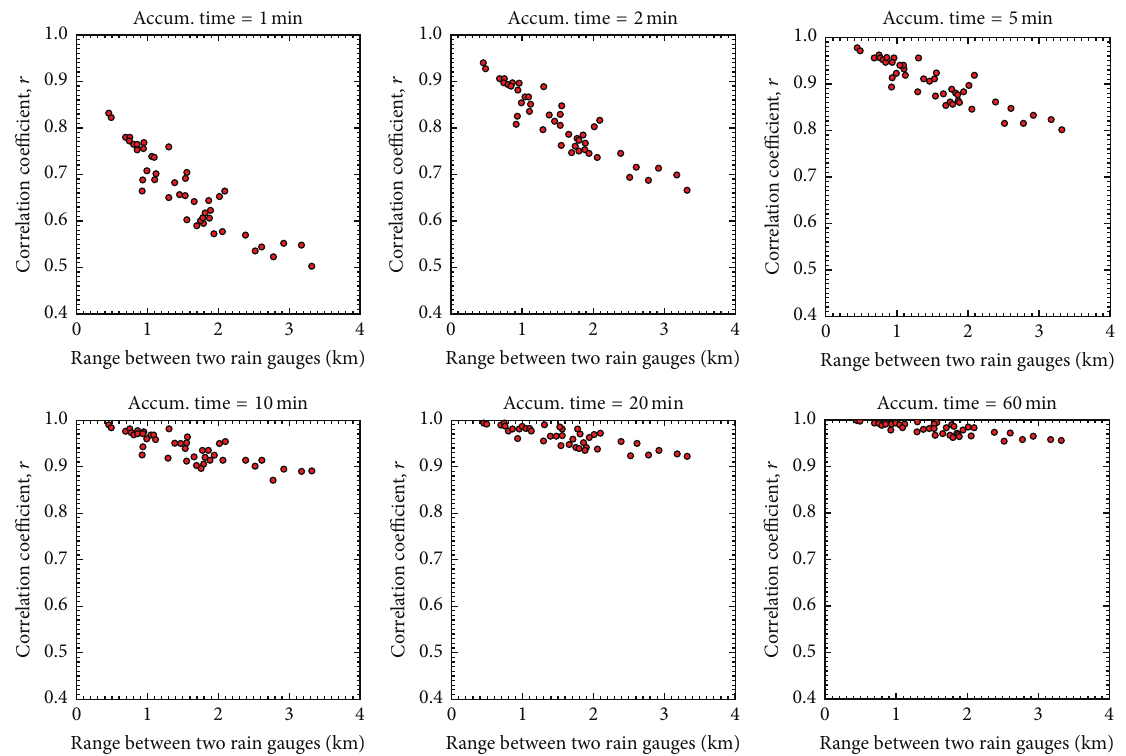
Figure 14: The Spearman correlation coefficient 𝑟 between data from two rain gauges at different accumulation times.